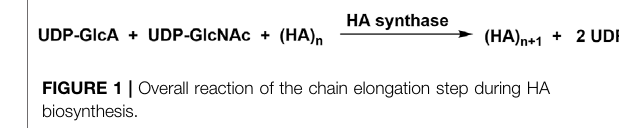
FIGURE 1 | Overall reaction of the chain elongation step during HA